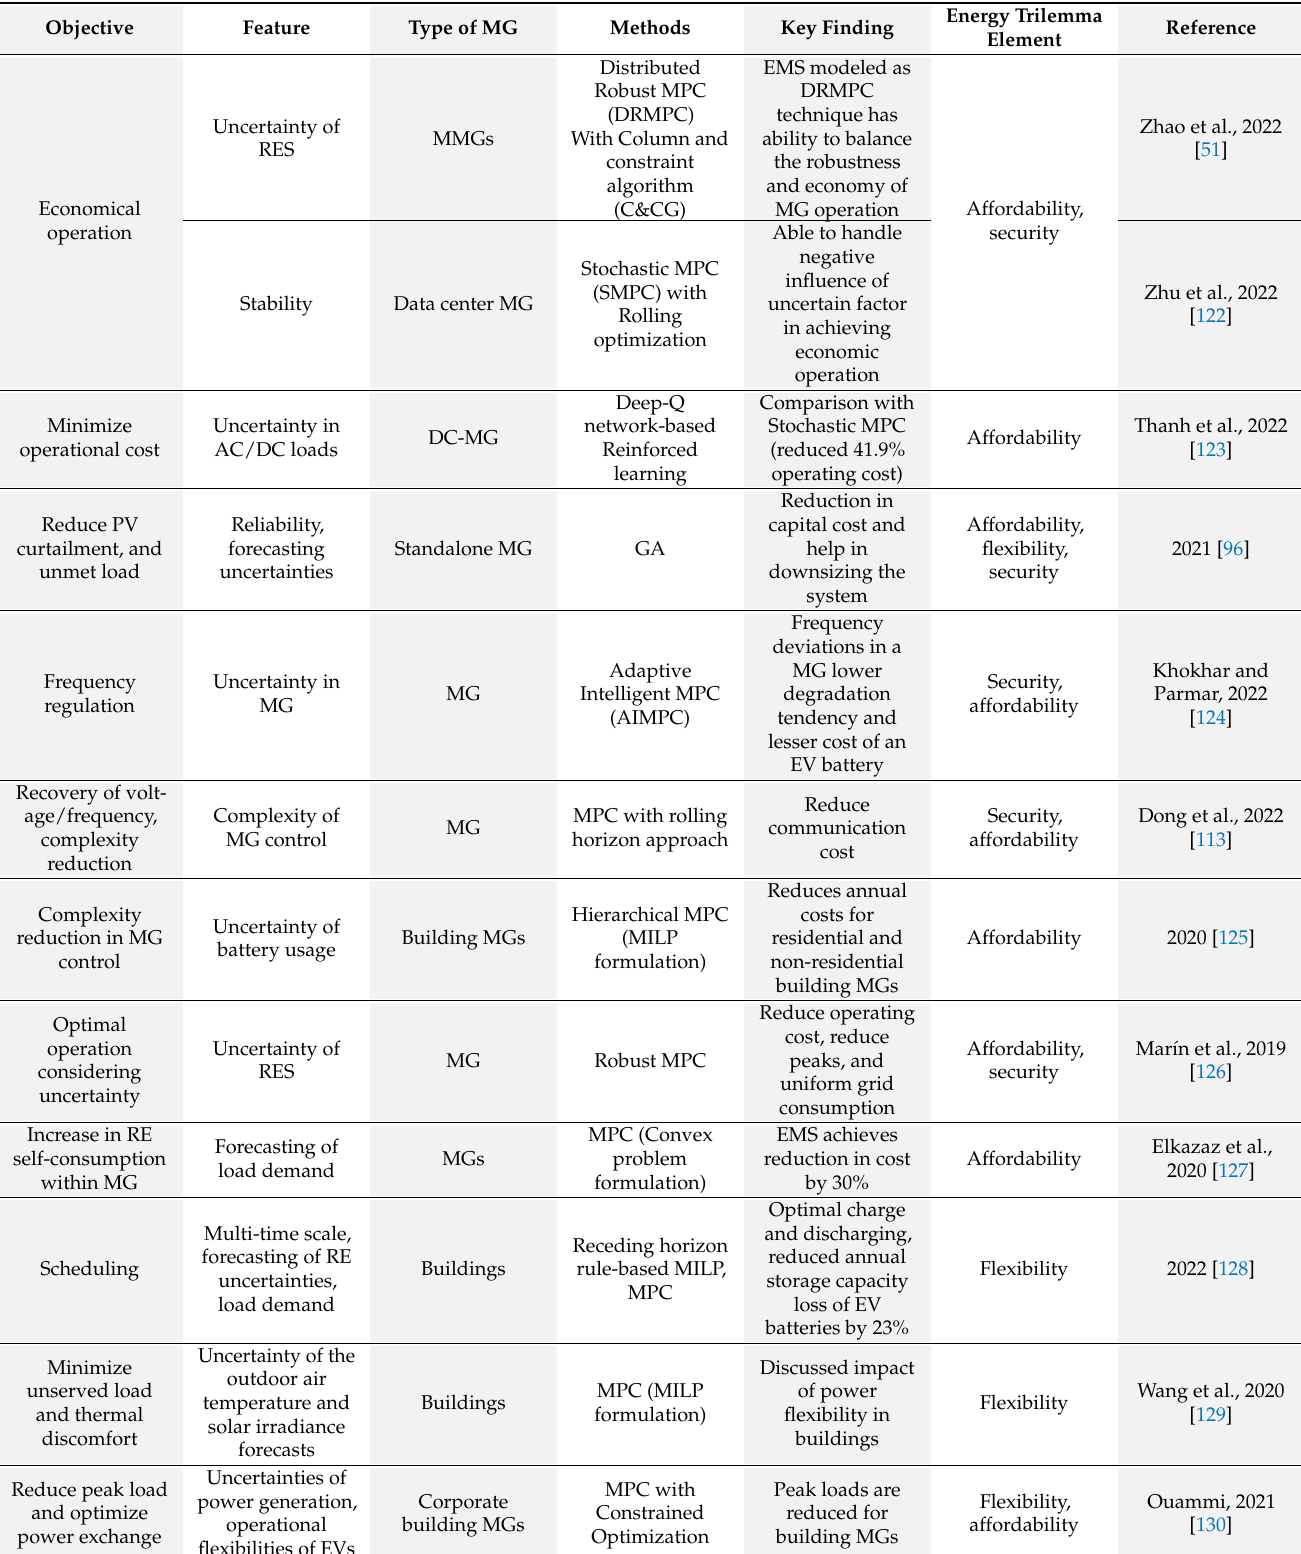
Table 4. MPC control approach with objectives and their relation to energy